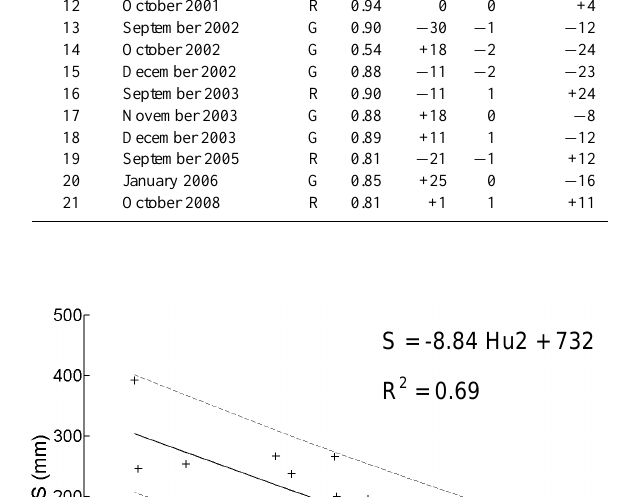
Fig. 7. Regression between the initial condition S and the base flow Figure 7: regression between the initial condition S and the base flow at Lavalette gauging 3 at Lavalette gauging station. The dashed lines represent the 95% confidence limits. station. The dashed lines represent the 95% confidence limits. 4